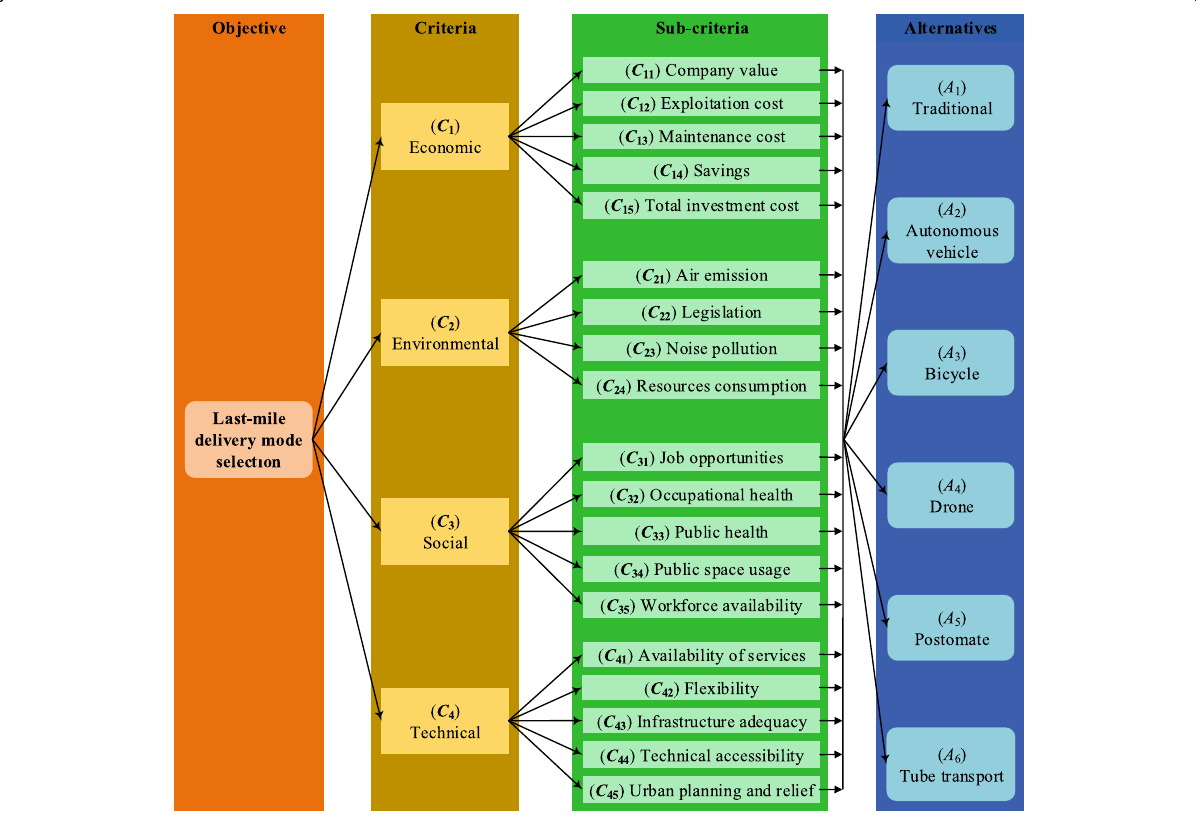
Fig. 6 The hierarchical structure of the last-mile delivery mode selection